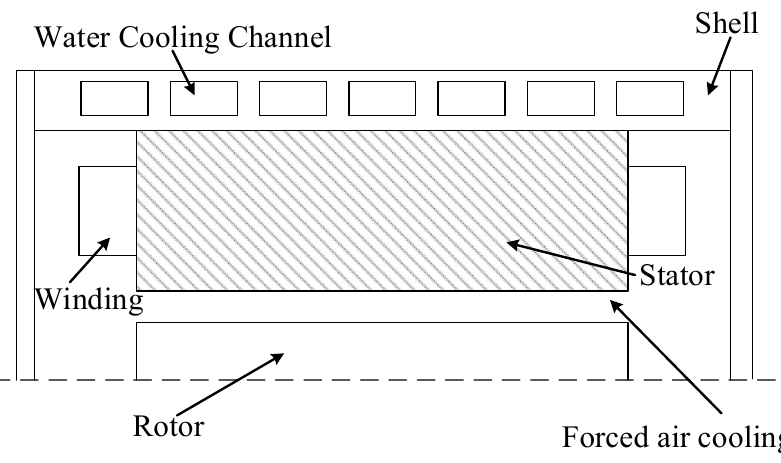
Figure 11. Cooling